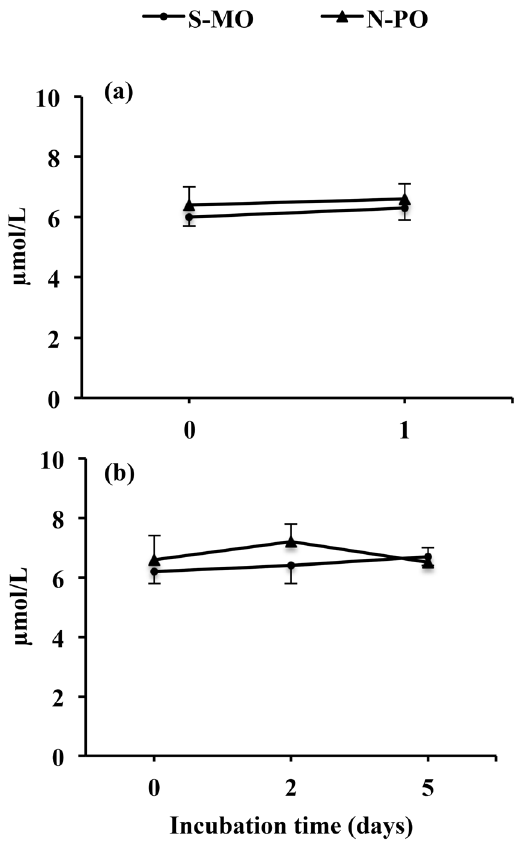
Figure 2. POVs in oils incubated with IVM and embryo culture media. Drops of IVM or embryo culture medium were covered with Sigma mineral oil (S-MO) or Nidoil paraffin oil (N-PO) and incubated for 0 and 1 day (IVM medium) ( a ) or for 0, 2 and 5 days (embryo culture medium) ( b ) under the same conditions used for IVM or embryo culture but without oocytes or embryos. At the end of the incubation, the oil overlay was removed with a micropipette and transferred to 5-mL tubes for the analysis. The POVs of both oils were below the recommended maximum value (8.5 µ mol/L), and these levels did not vary throughout the incubations. The data are presented as the mean ± SD (three